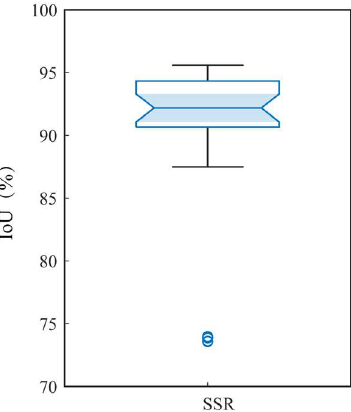
Figure 9. The IoU of 30 pairs of real-world images. The hingers indicate the 25th, 50th, and 75th percentiles of accuracy, respectively. The whiskers extend to the min and max data points not considered outliers, and the circles are outliers.